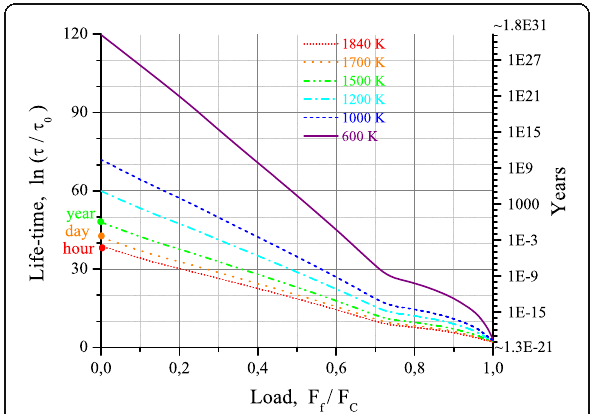
Fig. 8 Lifetime dependence on load over the wide temperature